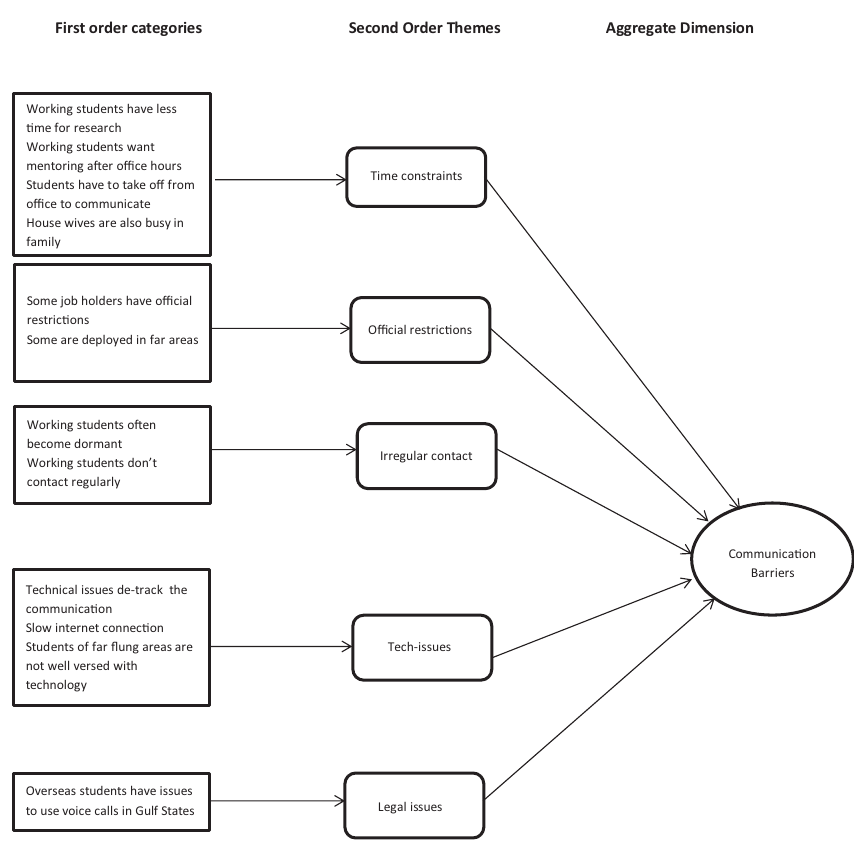
Figure 1. Communication